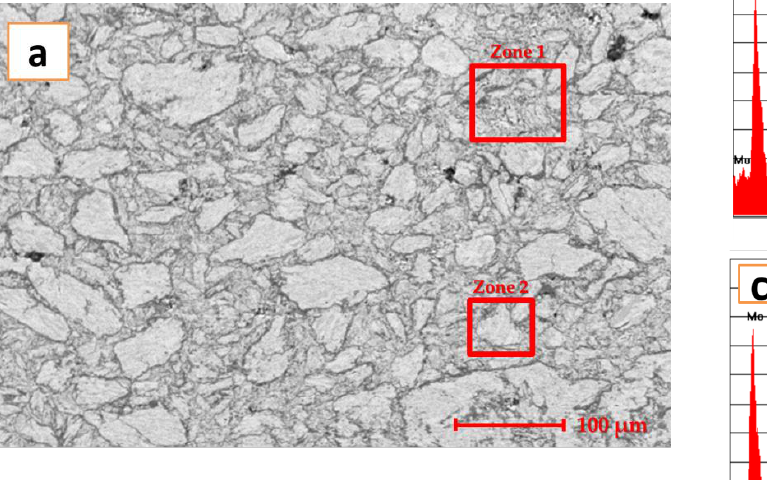
Figure 4. CoCrFeNiMo 0.85 HEA coating; ( a ) SEM images of the top view ( b ) SEM images of the cross-section ( c ) EDS anal- yses results for the coating.